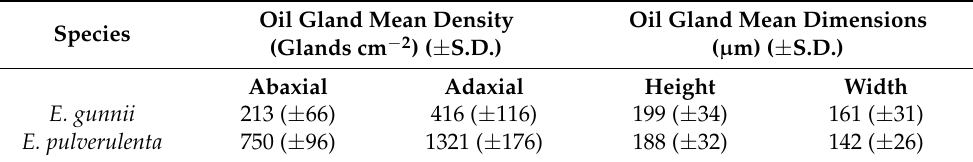
The data of gland density and dimensions are expressed as mean ± S.D. Oil gland density. EG: abaxial vs. adaxial, p < 0.01, n = 12; EP: abaxial vs. adaxial, p < 0.01, n = 12; EG: abaxial vs. EP abaxial, p < 0.01, n = 12: EG: adaxial